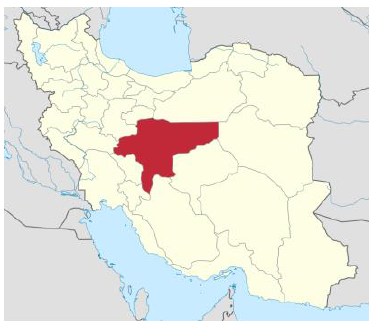
Figure1.The location of Esfahan